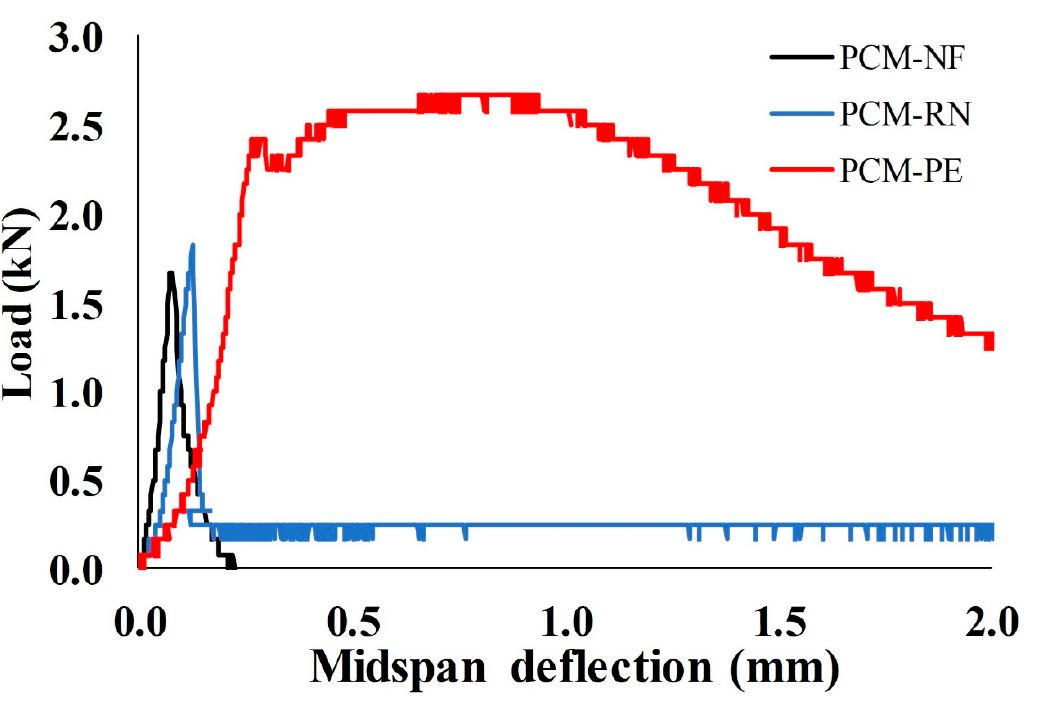
Figure 4. Load-midspan deflection curves of PCM–NF, PCM–RN and PCM–PE.